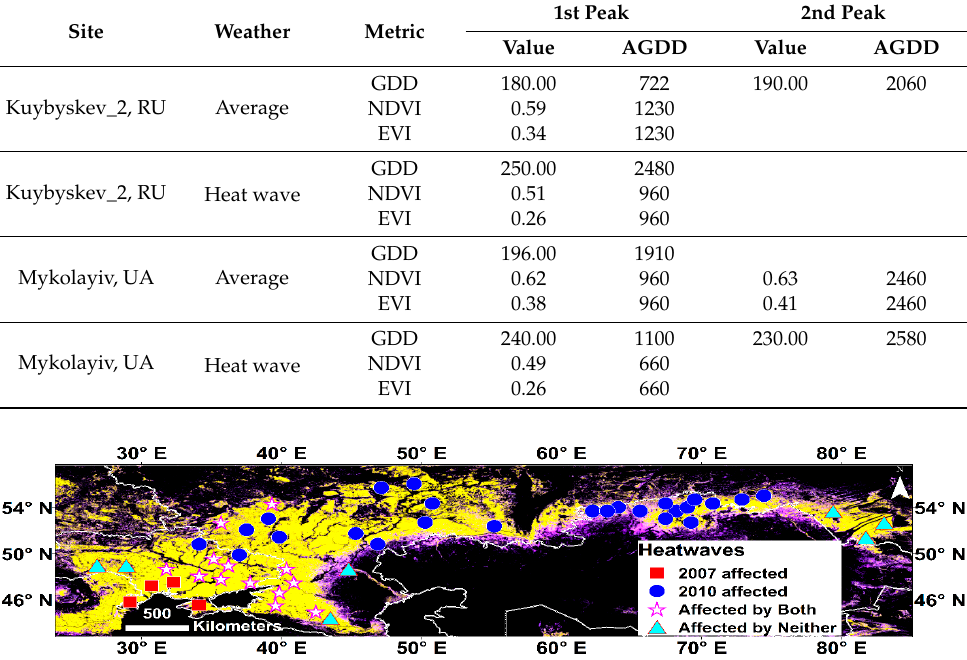
Figure 14. Comparison of VIs and GDD at similar places during heat wave years (Kuybuskev 2 ( a ), Russia in 2010 and Mykolayive ( b ), Ukraine in 2007) and average years (Kuybuskev 2 ( c ), Russia in 2005 and Mykolayive ( d ), Ukraine in 2009). N.B: GDDs are eight-day sums. Table 6. Peak GDDs and VIs and corresponding AGDDs during heat wave years and average years at two representative sites.